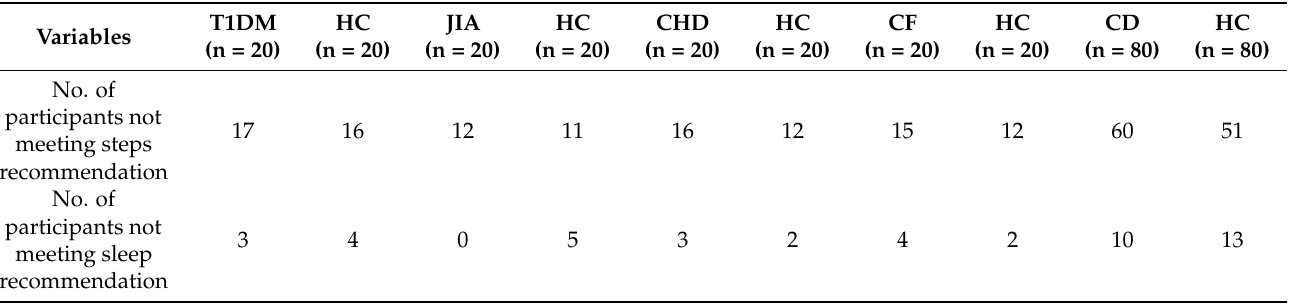
CHD—congenital heart disease; CF—cystic fibrosis; JIA—juvenile idiopathic arthritis; T1DM—type1 diabetes mellitus. Combined data represented total children with chronic disease (CD n = 80, mean age 6.9 years (SD = 2.0), and F:M 43:37) as one group and total healthy controls n = 80, mean age 6.8 (SD = 1.9) and F:M 43:37) as one group. Steps recommendations per day 10,000–14,000 steps/day in children aged 4–6 years, 13,000–15,000 steps per